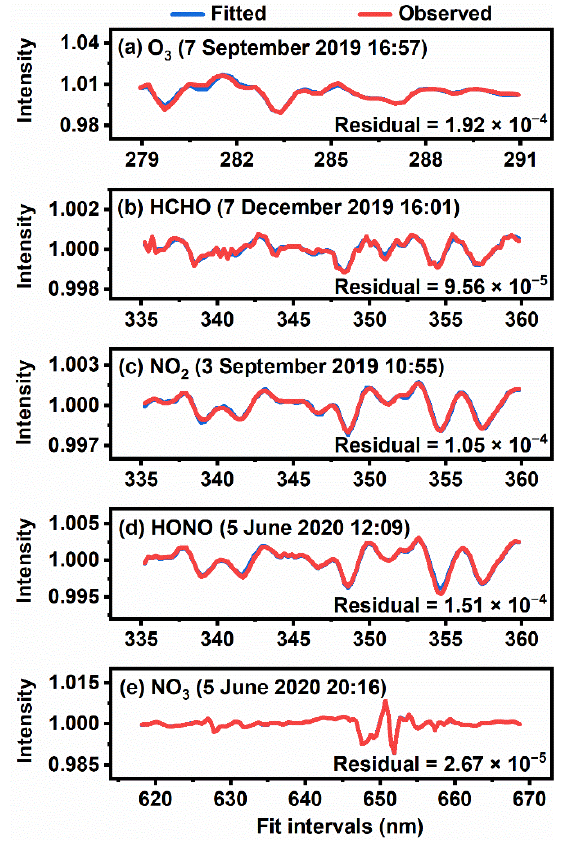
Figure 2. Examples of typical DOAS spectral fitting results for O 3 ( a ), HCHO ( b ), NO 2 ( c ), HONO ( d ), and NO 3 ( e ) including the observed and fitted result.